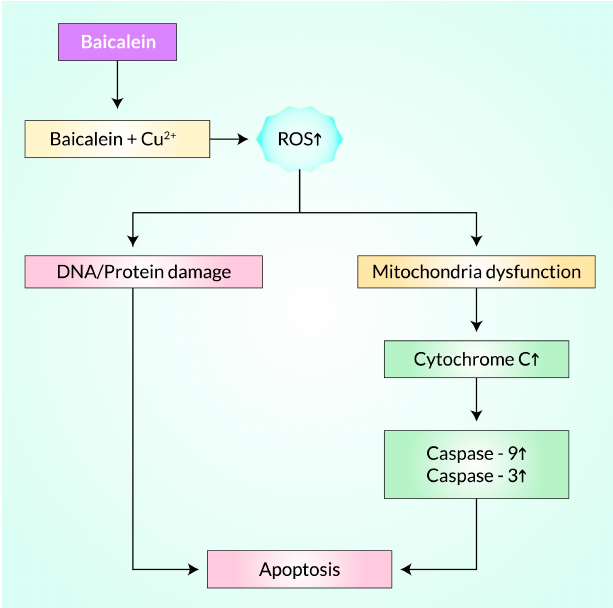
Figure 2. Predictive mechanism of Baicalein-induced apoptosis through regulating ROS signaling in cancer cell lines. This figure modified after Liu et al.